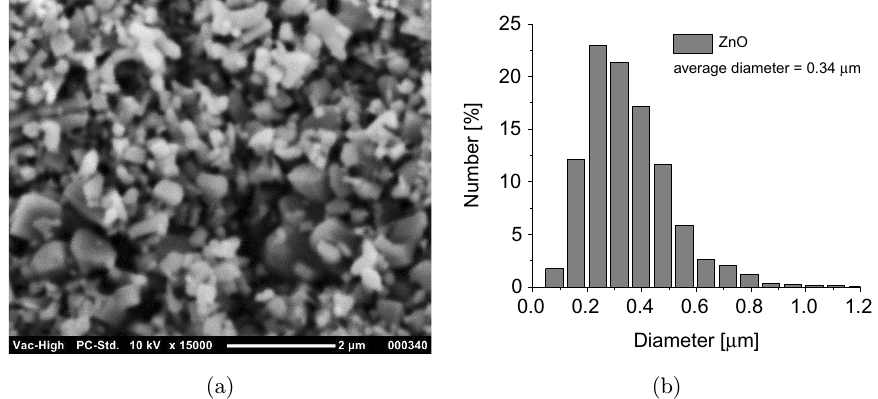
Fig. 2. Scanning electron microscopy (SEM) image (a) and size distribution (b) of the used ZnO